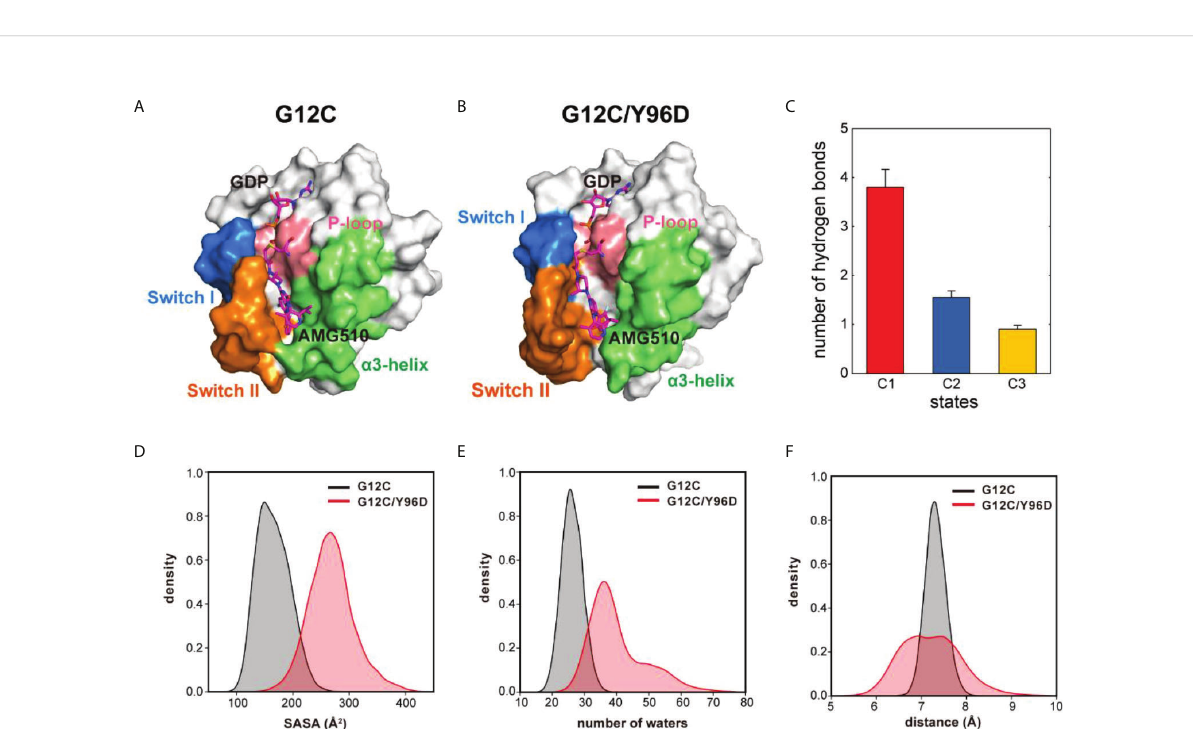
FIGURE 4 The Y96D mutation induced the opening and loosening of the binding pocket. (A) The surface representation of the representative structure of the G12C system. (B) The surface representation of the representative structure of the G12C/Y96D system. (C) The number of hydrogen bonds formed between the switch II and a 3-helix in each state. (D) SASA of AMG510 in the G12C system (black) and the G12C/Y96D system (red). (E) Number of waters in the 5.4 Å watershell of AMG510 in the G12C system (black) and the G12C/Y96D system (red). (F) The distance between the CB atom of residue 96 and the centroid of azaquinozoline of AMG510 in the G12C system (black) and the G12C/Y96D system